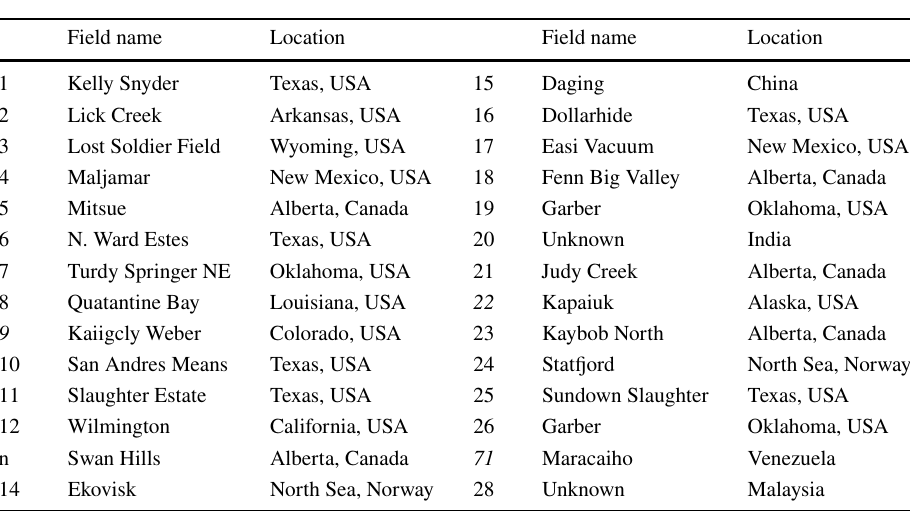
Table 1 Fields used during this research study (Christensen et al. 2001; Ramachandran et al. 2010; Sanchez 1999; Rosman et al.